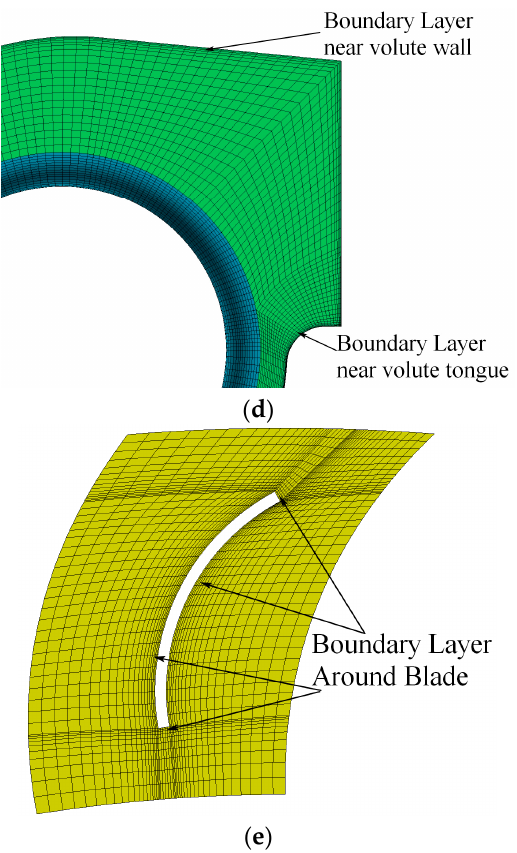
Figure 3 . Mesh of compute domain: ( a ) the overall structural mesh of the centrifugal fan; ( b ) the mesh of the volute; ( c ) the mesh of the impeller; ( d ) the boundary layer of the volute; ( e ) detail of the mesh near the blade.